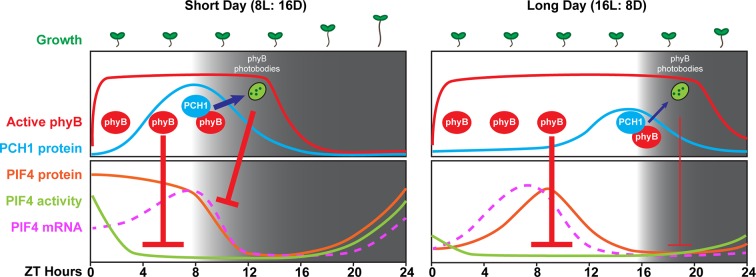
A model of PCH1-regulated day-length specific growth.A proposed model illustrates the role of PCH1 in controlling the photoperiodic hypocotyl elongation response. In short days, PCH1 peaks at dusk (ZT 8), maintains phyB photobody formation to suppress PIF4 levels and activities (downstream gene expression) to suppress hypocotyl elongation in the early evening. In long days, PIF4 peaks in the middle of the day and is repressed by active phyB. PIF4 protein decreases to basal level prior to dusk (Figure 8—figure supplement 1 and Yamashino et al., 2014), therefore no longer requiring the additional suppression mediated by PCH1-regulated phyB photobodies in the evening.